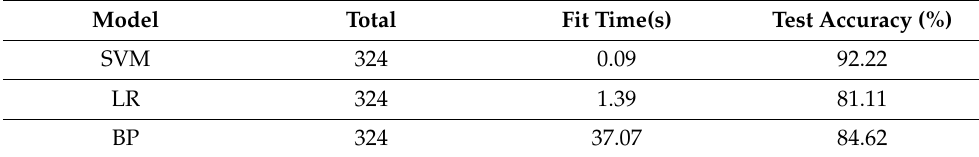
Table 2. Performance of each model in 5-fold cross validation.